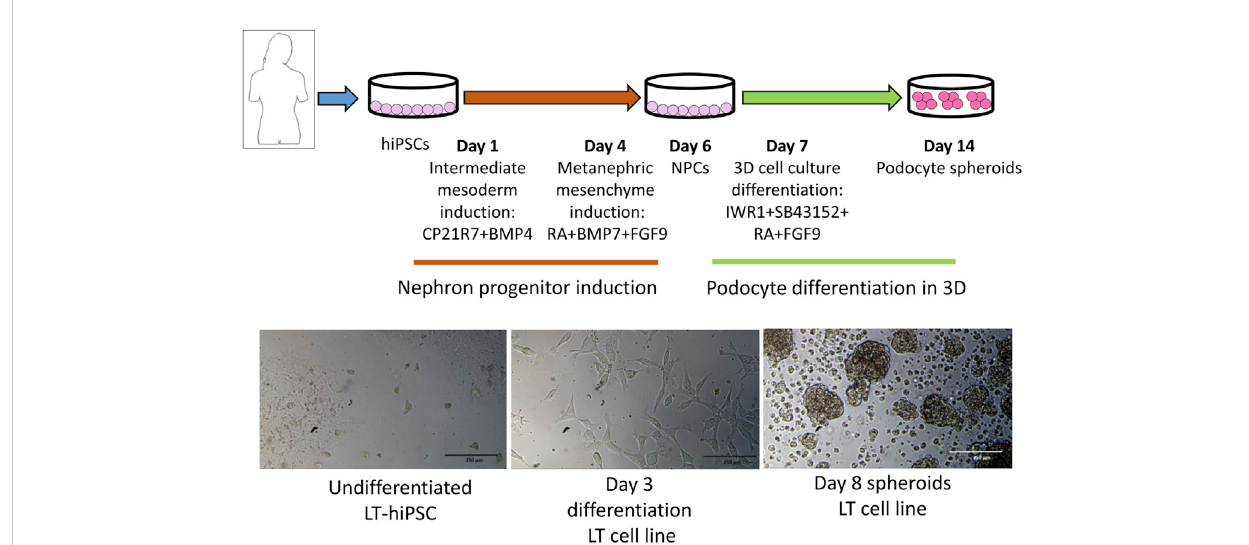
FIGURE 1 Protocoloutline highlightingthedifferentstagesandinductionmediausedtoinduceintermediatemesoderm,nephronprogenitorcells(NPCs)and podocytes. At the bottom are representative images of different differentiation stages.